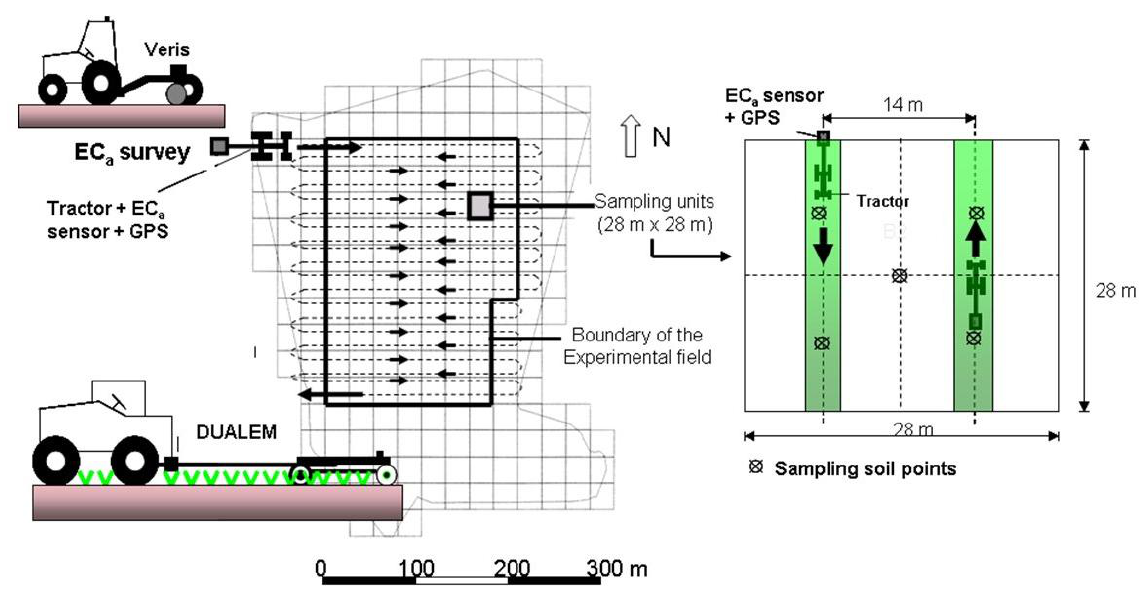
Figure 2. Diagram illustrating the procedure used to survey the soil electrical conductivity ( left ) and to collect soil sampling in each square ( right ) in the experimental